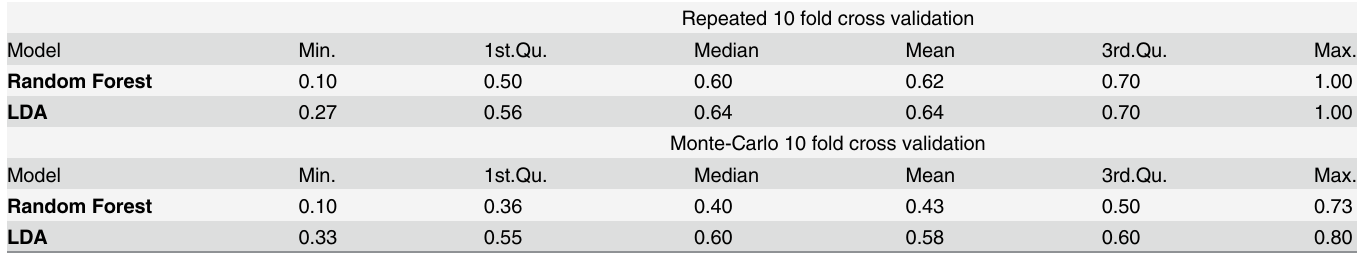
Table 3. Accuracy results of PSA testing for prostate cancer assessed with repeated 10 fold cross validation of Random Forest and Linear Dis- criminant Analysis (LDA)